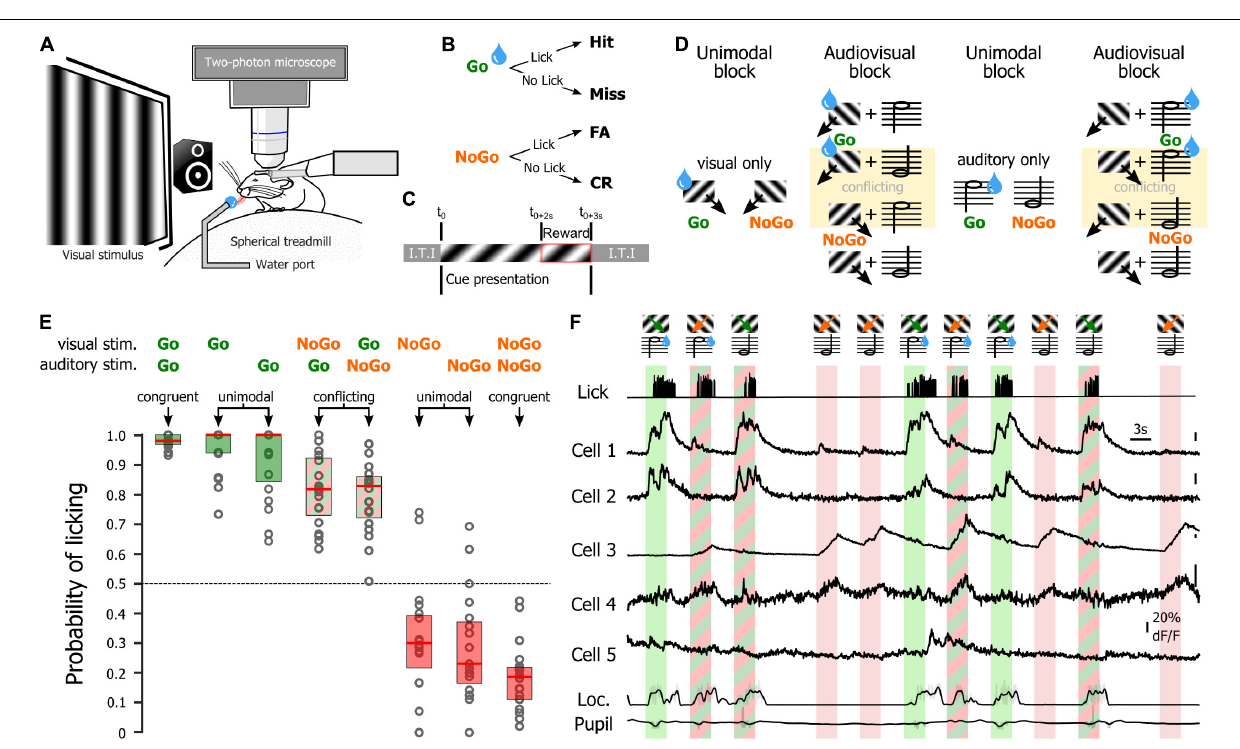
FIGURE 5 | Recording sessions in trained mice. (A) Schematic representation of the recording setup. (B) Potential behavioral outcomes for a trial. (C) Trial time course. Inter Trial interval (I.T.I) after Hit and CR: 3 s; I.T.I after Miss and FA: 12.5 s. (D) Stimuli shown during the unimodal, audiovisual, and tuning blocks in a session starting with visual reward. Water drops indicate stimuli that are rewarded for that block. (E) Mouse licking probability for the different unimodal and audiovisual stimuli. (F) Activity of neurons during the presentation of the visual stimuli of the audiovisual block (auditory reward). The neuronal activity was recorded simultaneously with the licking activity (top trace), the locomotion of the animal as well as the pupil size (bottom